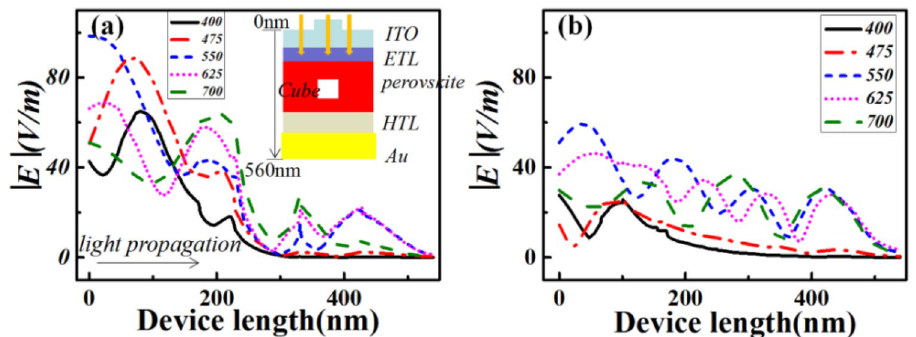
Figure 7. Device position (along with the z -direction)-dependent| E |profiles of the optimized case V ( a ) and reference ( b ) at several typical incident wavelengths. The upper-right inset of a schematically illustrates the device layer